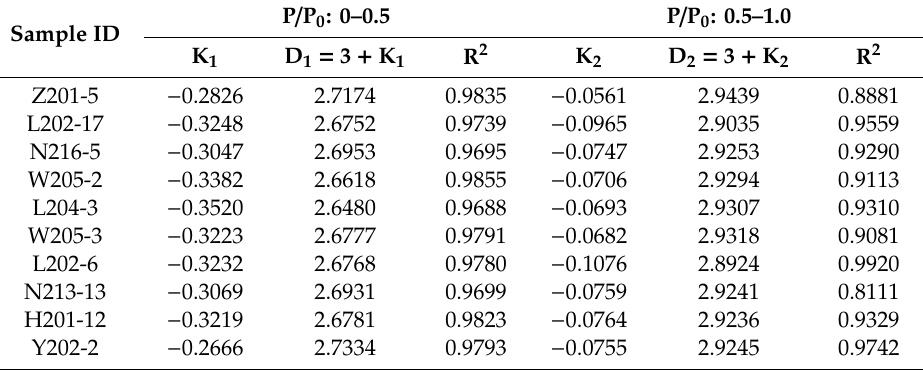
Figure 15. Fractal analyses of two representative shale samples W205-2 ( A ) and L204-3 ( B ) based on nitrogen gas desorption isotherms. Table 2. Fractal dimensions calculated by the FHH model based on N 2 desorption isotherms.